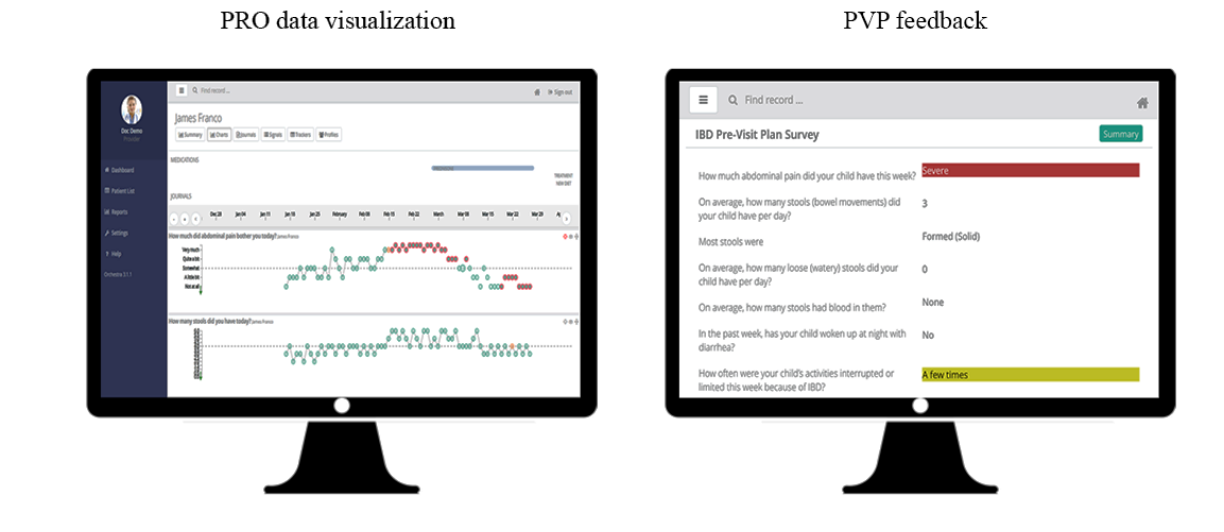
Figure 2. “Orchestra” clinician dashboard example screens. PRO: patient-reported outcome; PVP: previsit